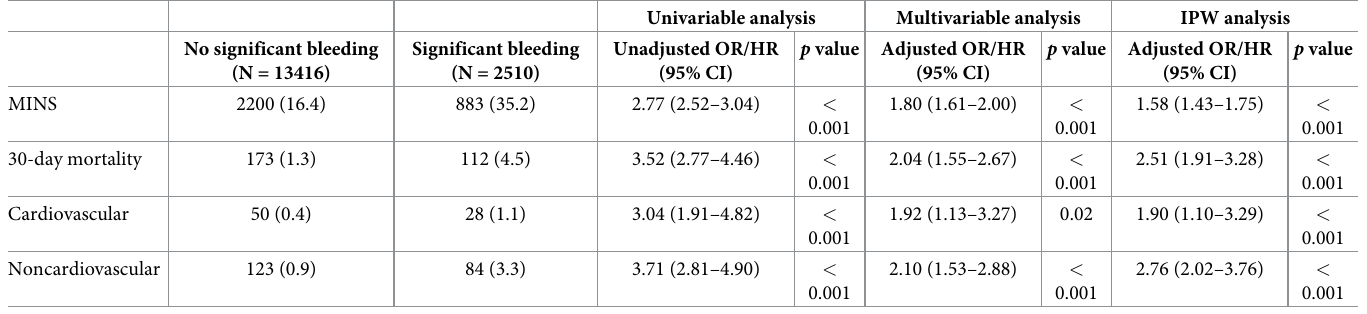
Table 2. The incidence of myocardial injury after noncardiac surgery and mortality.